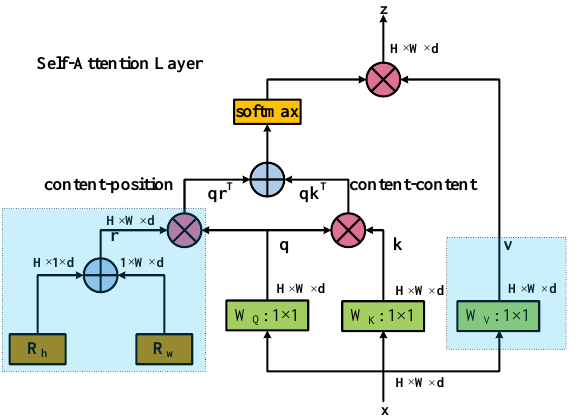
Figure 10. MHSA applied to BoT3. MHSA also uses four heads. q, k, and v represent query, key, and value encodings, respectively. ⊕ and ⊗ represent element-wise sum and matrix multiplication operations. 1 × 1 represents 1 × 1 convolution.